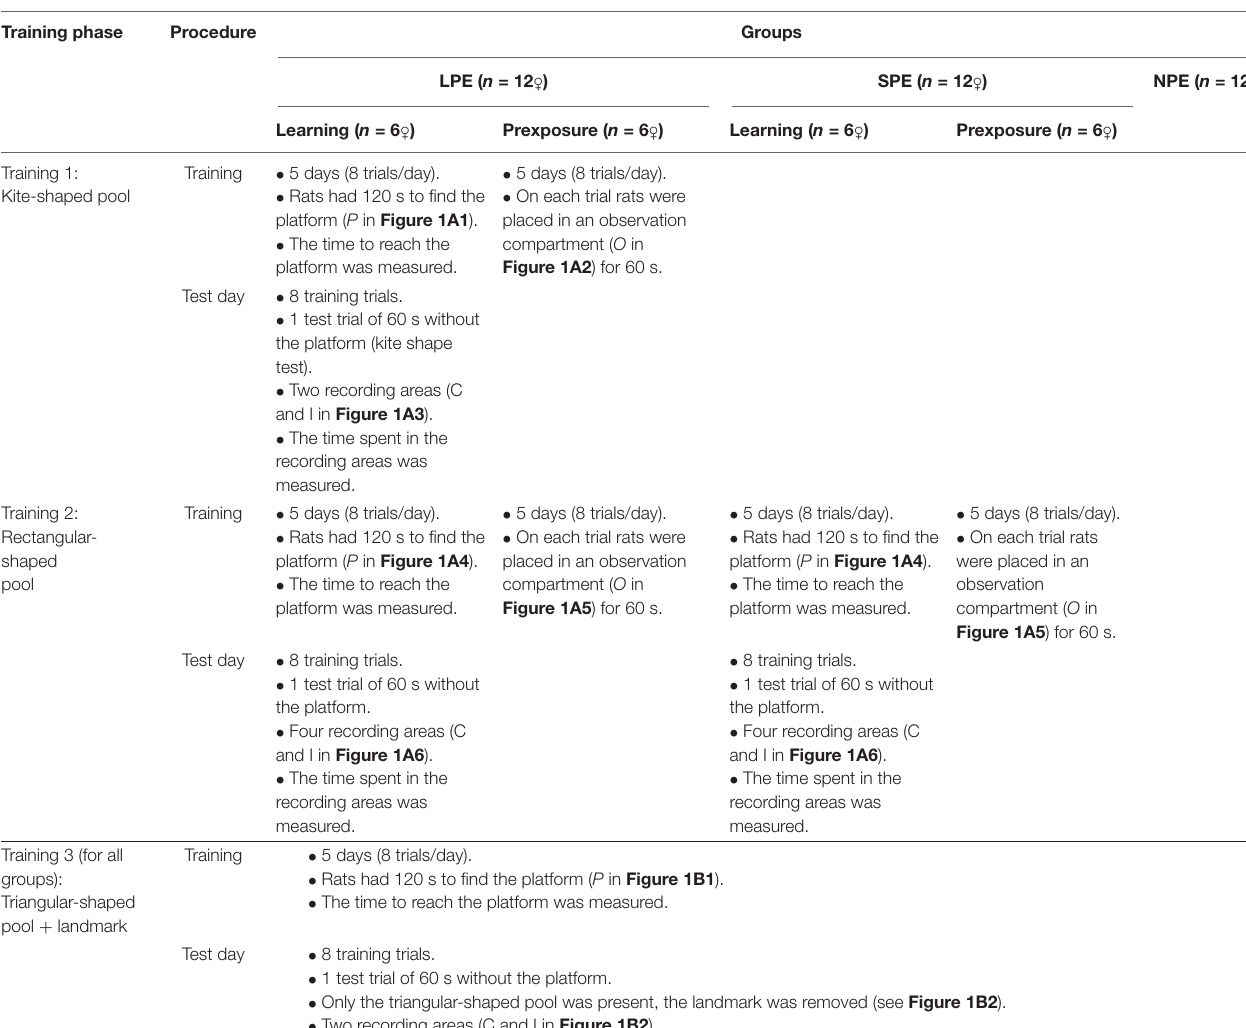
TABLE 2 | Procedure of Experiment 1 ( n =